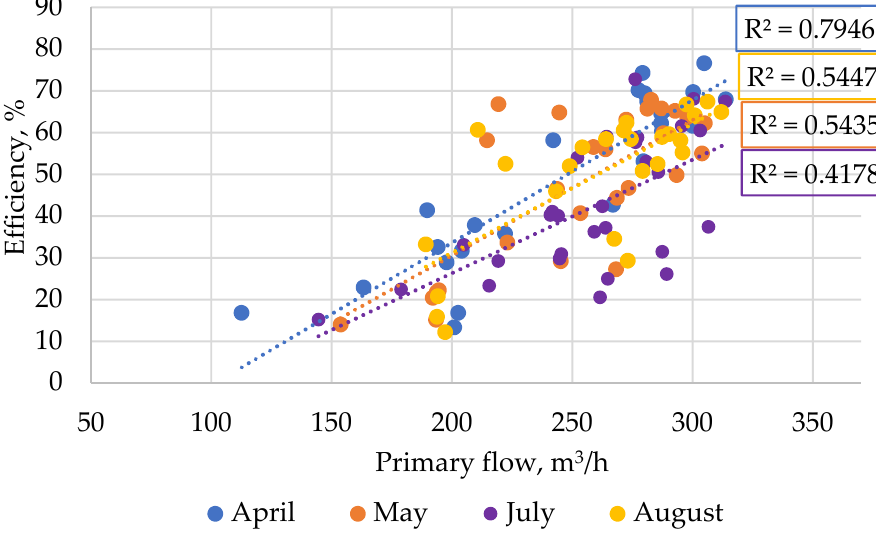
Figure 5. Correlation of heat carries primary flow rate and solar field efficiency.